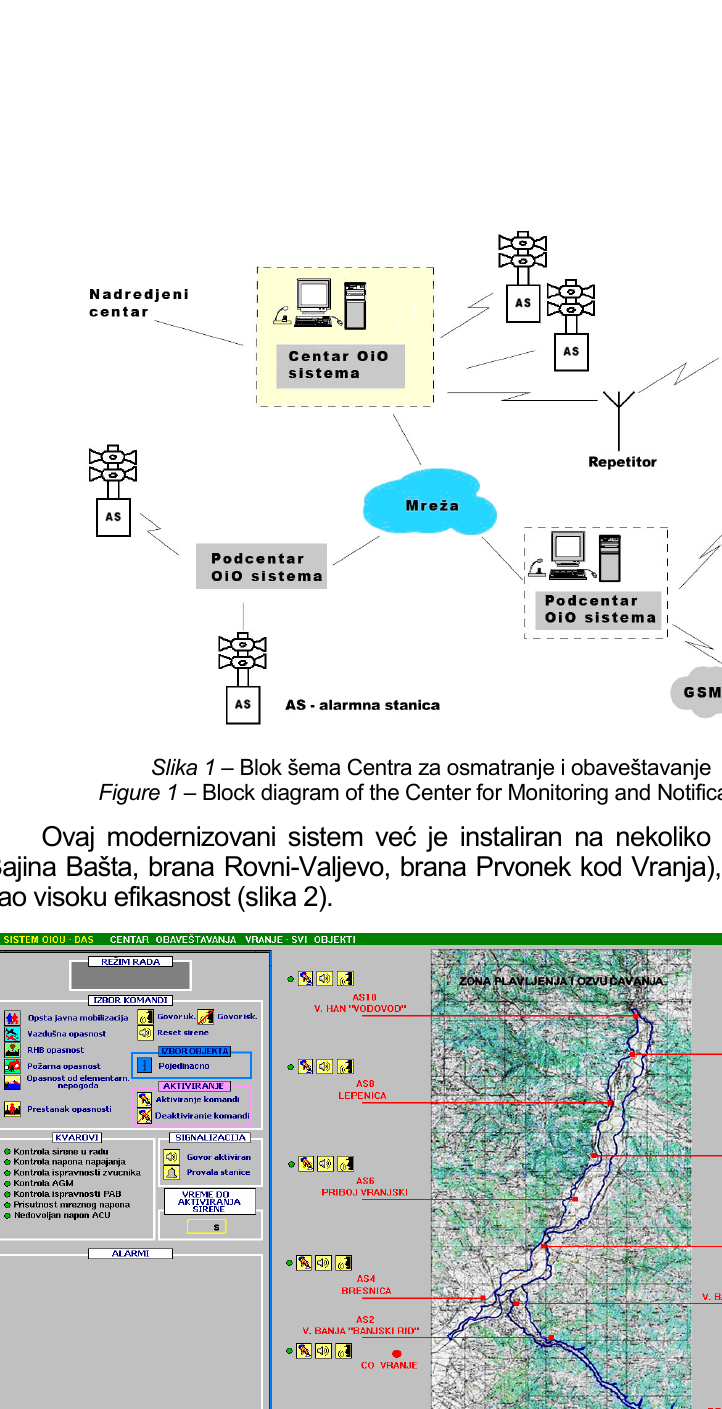
Figure 2 – Window management system of OI on the Prvonek dam near